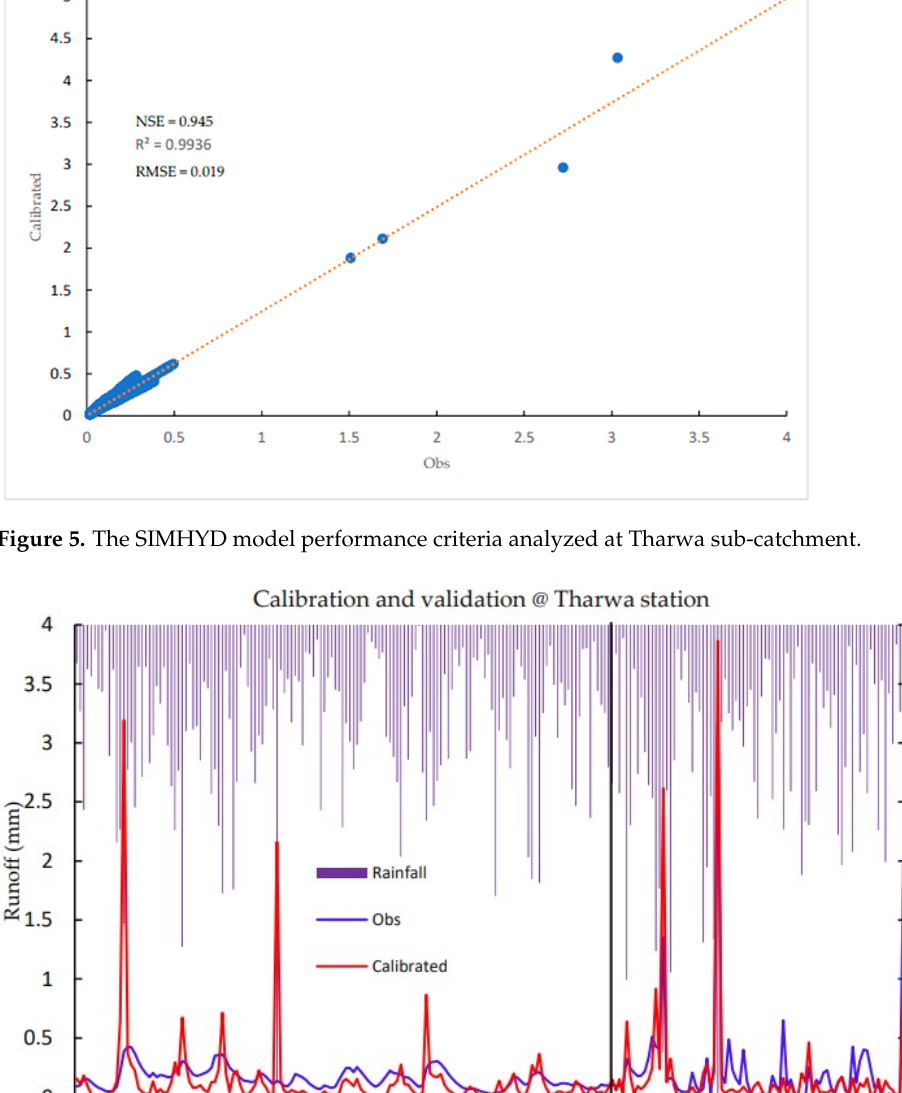
Figure 6. A comparison between observed and SIMHYD modeled runoff during calibration and validation period at Tharwa station. Figure 5. The SIMHYD model performance criteria analyzed at Tharwa sub-catchment.